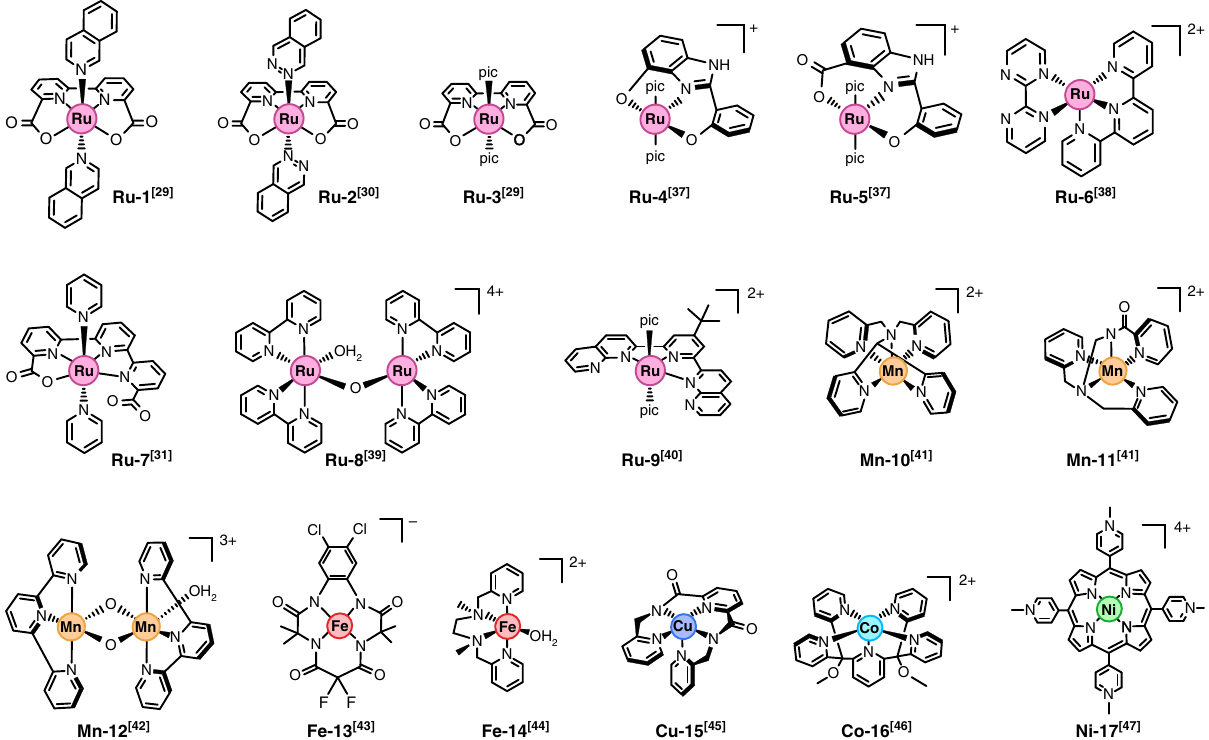
Fig. 2 Molecular OER catalysts investigated in this work, taken from refs. 29 – 31,37 – 47 . Chemical structures correspond to the vacancy intermediate in the OER mechanisms depicted in Fig. 1. The 4-picoline ligands in Ru-3-5 and Ru-9 have been replaced by “ pic ” for